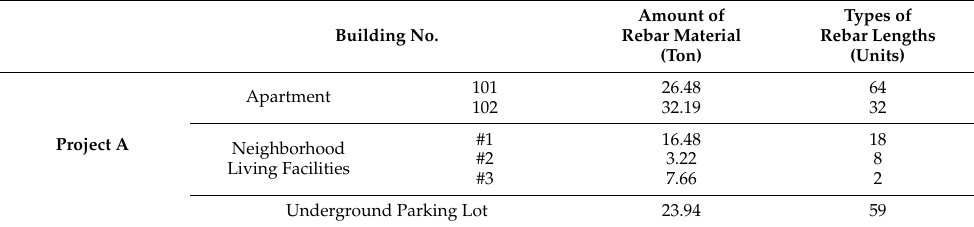
Table 3. The amounts of rebar material and the number of rebar LPRS for column members. Building